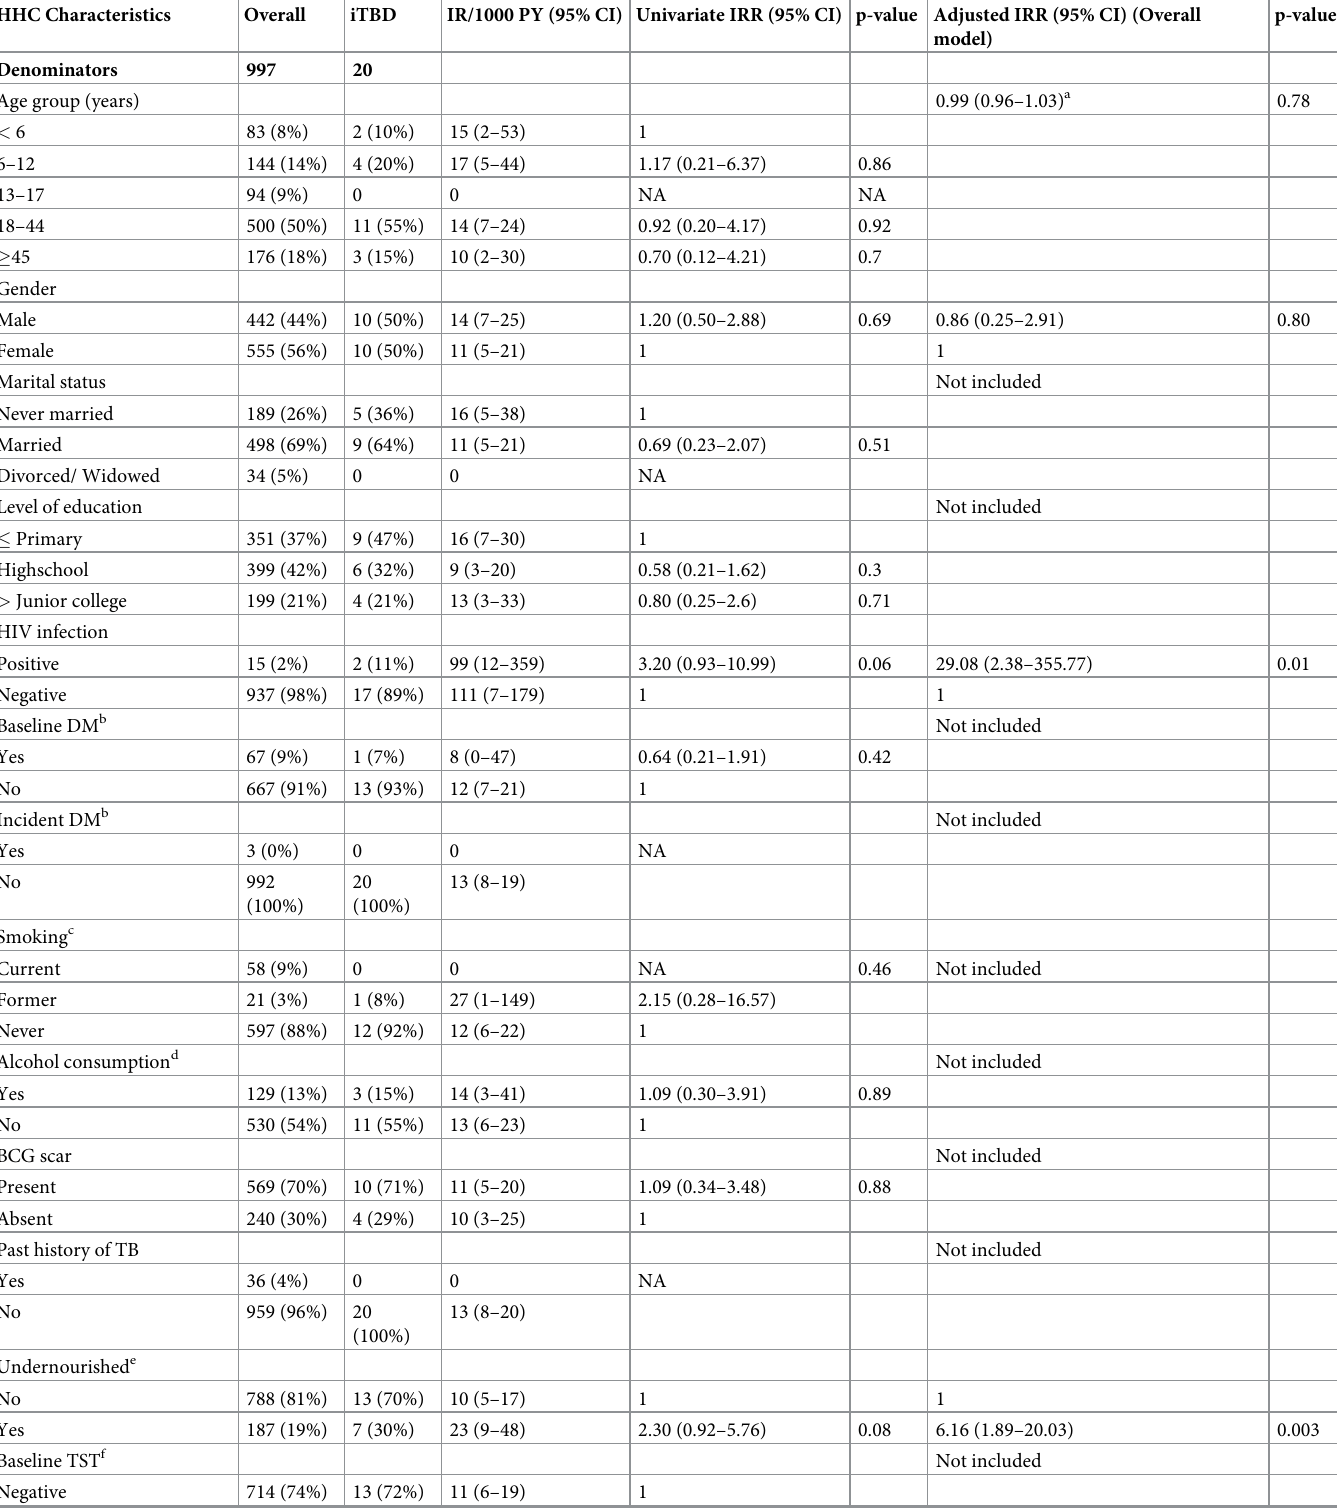
Table 1. Baseline characteristics of household contacts and risk factors for incident TB disease among household contacts of adult pulmonary TB patients in